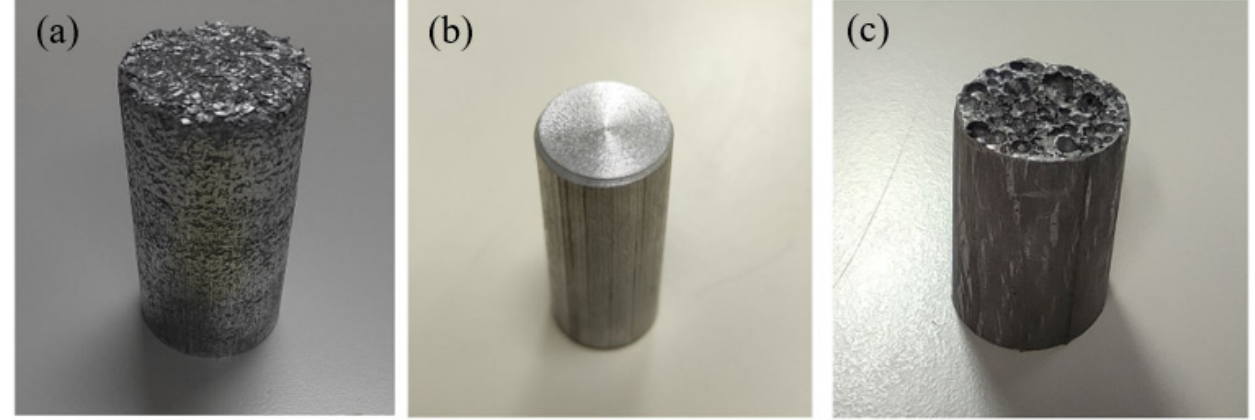
Figure 2. Material flow during chip-based foam production: ( a ) billet, ( b ) precursor, and ( c ) metal foam.